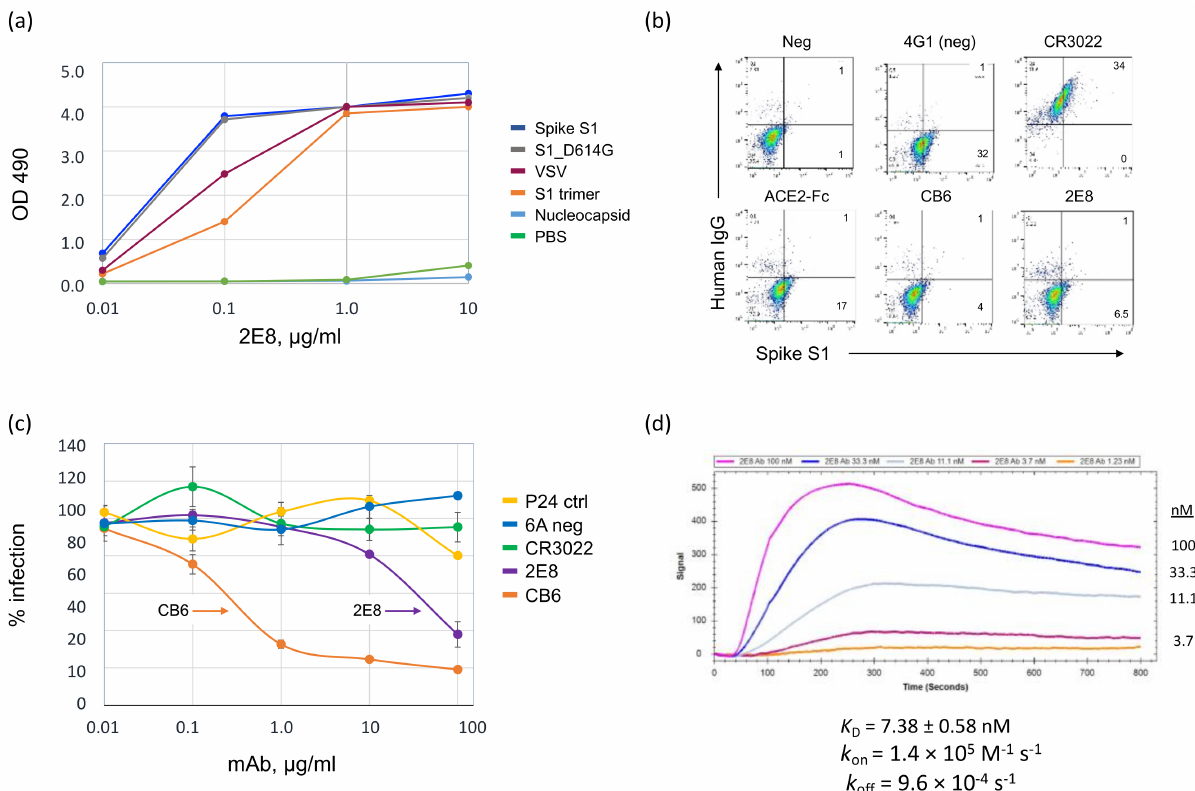
Figure 1. SARS-CoV-2 L strain (Wuhan-Hu-1) spike binding by the 2E8 human mAb. ( a ) The 2E8 mAb binding in a direct ELISA to SARS-CoV-2 antigens: S1, S1 D614G, and nucleocapsid (Sino Biologicals); spike-pseudotyped VSV particles; and a recombinant S1 trimer. Samples were tested in triplicate. Error bars = S.E.M. (not visible due to minimal differences). ( b ) S1 binding to 293T-hsACE2 cells in the presence of 2E8, 4G1 (isotype control IgG), CR3022, CB6, and an ACE2-Fc fusion protein was assessed by flow cytometry. S1 cell binding, x -axis; IgG binding, y -axis. ( c ) Pseudovirus neutralization assay. 293T-hsACE2 cells were transduced with SARS-CoV-2 luciferase (Wuhan-Hu-1 strain) reporter viral particles (RVPs) in the presence of the mAbs, 6A (isotype control IgG), CR3022, 2E8, and CB6, and a polyclonal IgG isolated from the 2E8 B cell donor (P24). Normalized percent infection is shown; samples were tested in triplicate. Error bars = S.E.M. ( d ) SPR analysis of 2E8 binding to the spike S1 domain, performed on the Nicoya OpenSPR™; KD = 7.38 ± 0.58